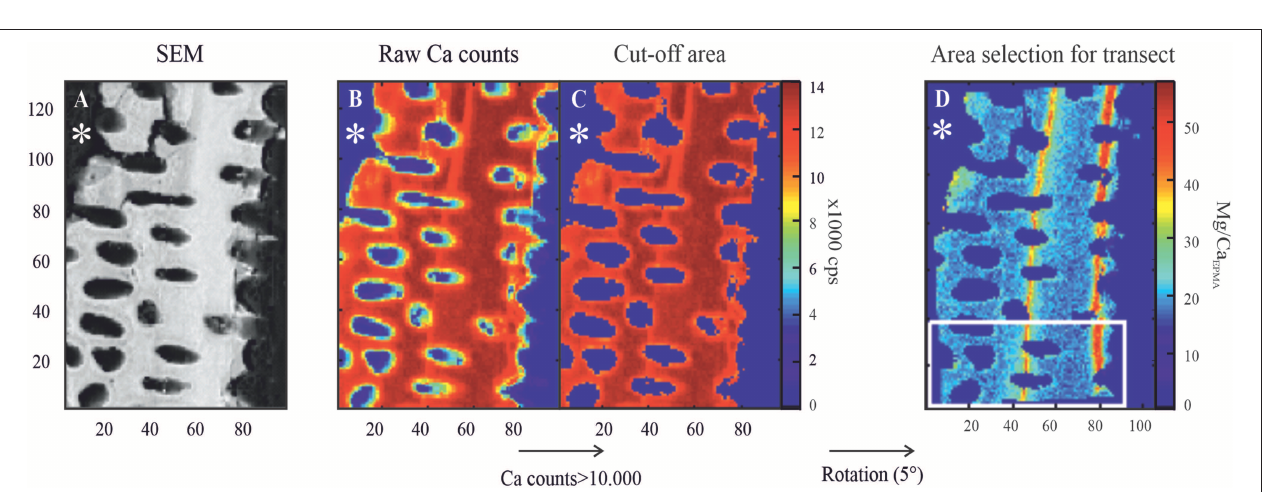
FIGURE 1 | Examples of SEM images of polished specimens of (A) Ammonia sp. T6 (B) , Bulimina marginata , and (C) Amphistegina lessonii . Chambers precipitated during the experiment are recognized owing to pre-staining (see Experimental Protocol section) and are numbered from final (F) to older chambers (e.g., F-1 and F-2). Scale bar is 100 µ m. SEM, scanning electron microscope.